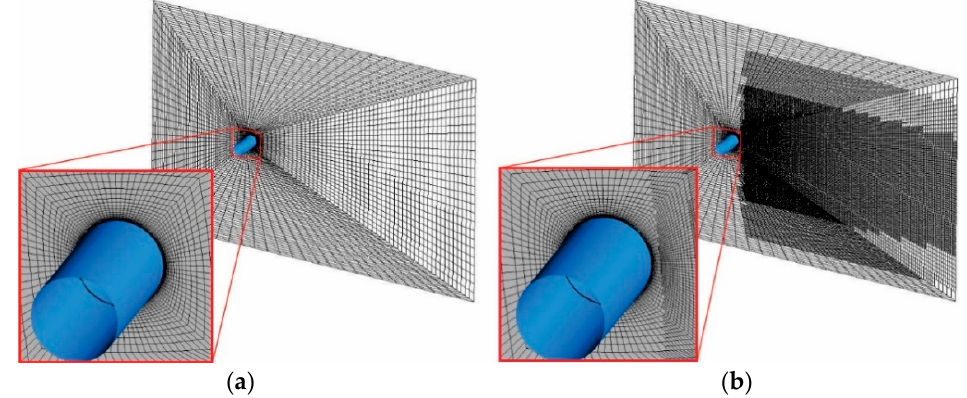
Figure 10. Contours of normalized Reynolds stress w (cid:48) w (cid:48) /U 2 center of the cube at z / H = 0 for all three tested turbulence models on the uniform coarse and regular meshes and the non-uniform clustered mesh.